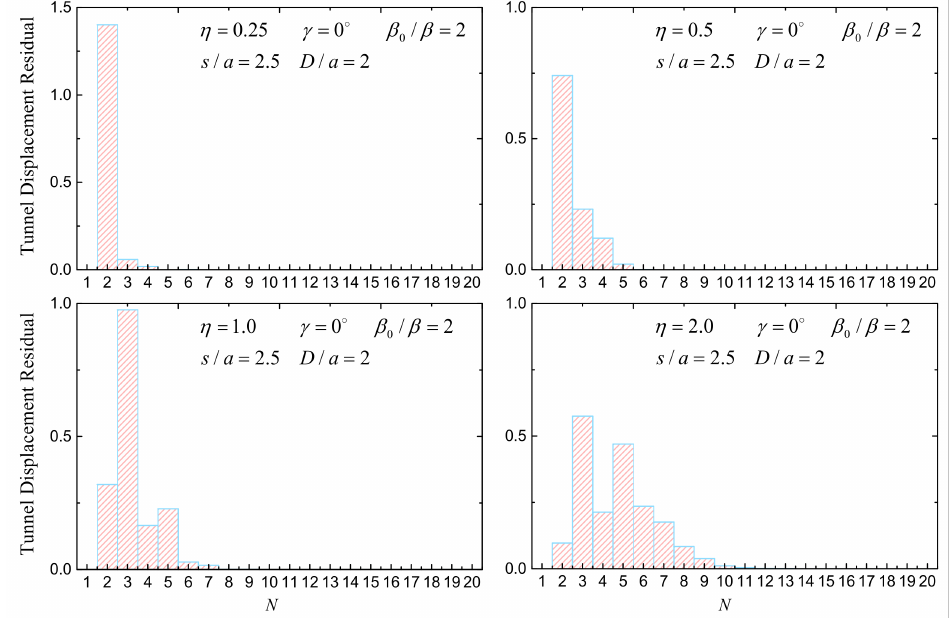
Figure 3. Tunnel displacement residuals